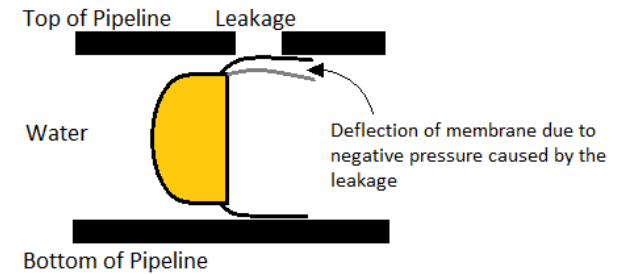
Figure 35. The deflection of the membrane on the detector of PipeGuard when a leak is present. Modified from